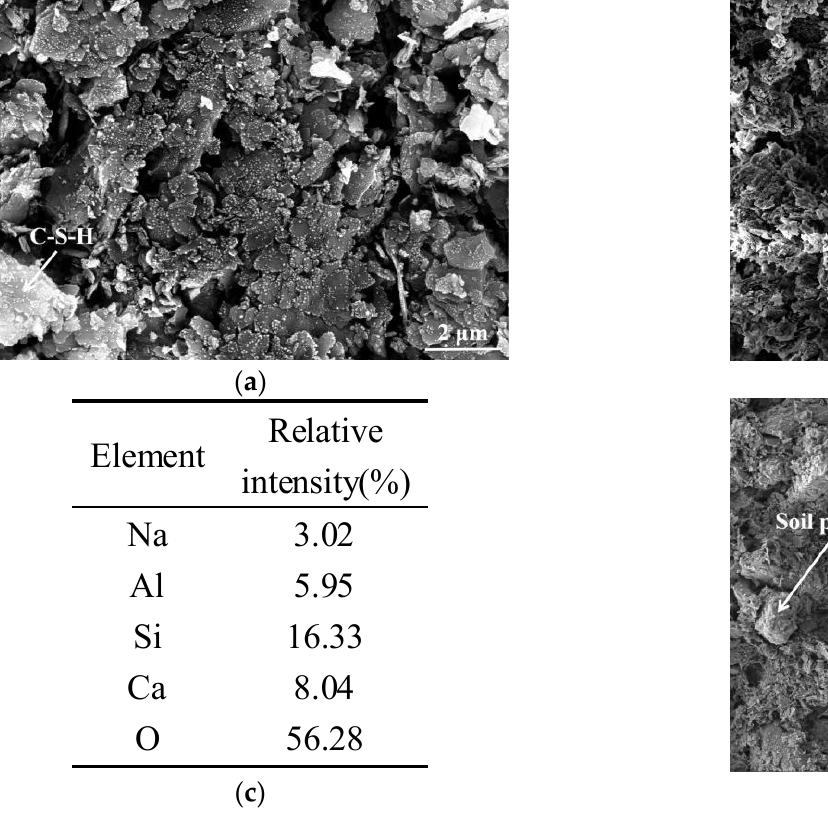
Figure 6. SEM images of C-2: ( a ) and ( b ) 7 d; ( c ) EDS result—7 d; ( d ) 28 d. It can be seen from Figure 7a,b that the slag and fly ash rapidly hydrate in the presence of the alkaline activator, generating a large number of uniformly distributed gelatinous products which bind the soil particles together. Compared with C-2, II-3 forms a denser microstructure, which is manifested as an increase in the UCS from a macro perspective, as described in Section 3.3. In addition, almost no spherical fly ash particles are observed in the SEM image. This indicates that the activity of fly ash is activated in the alkaline environment generated by the alkaline activator, so that the fly ash particles are gradu- ally covered by the generated hydration products [40–42,52]. The EDS analysis result of Figure 7c shows that the geopolymer gel (point c) is composed of hydrated calcium silicate (C-S-H) and sodium-based aluminosilicate (N-A-S-H). The N-A-S-H gel is mainly formed the alkali–fly ash system [44,50,52]. As shown in Figure 7d, the internal particles of the geopolymer soil sample at 28 d are fully bonded and consolidated to form a